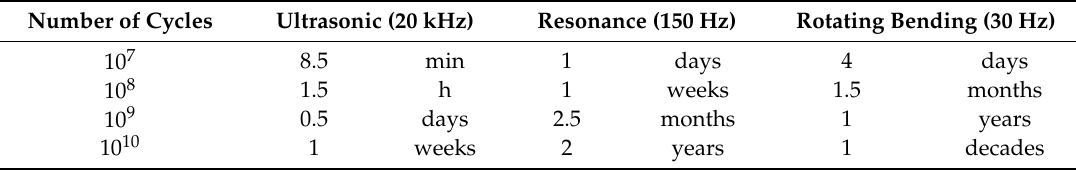
Table 1. Comparison between the duration di ff erent fatigue testing methods need to be